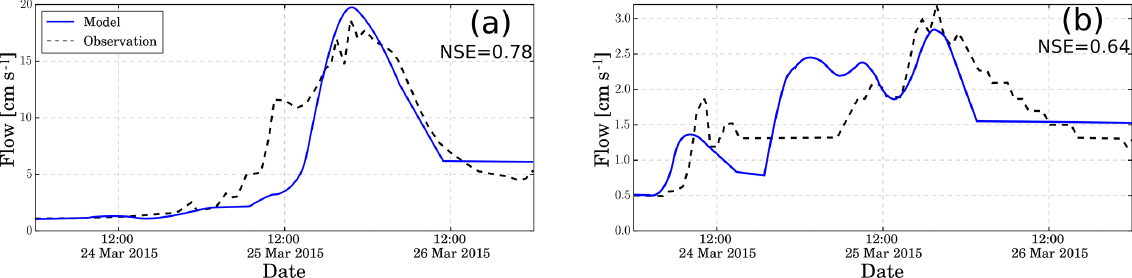
Figure 2. Calibration records for stream gauge stations (a) Río El Carmen en El Corral and (b) Río Conay en Las